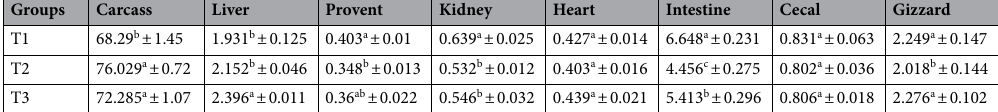
Table 3. Effects of ZnONPs supplementation on carcass and internal organs’ relative weight (gm/100 gm) of broiler chicks. Values are means ± SEM. a, b, c—Means in the same column with different superscripts are significantly different ( P <0.05).